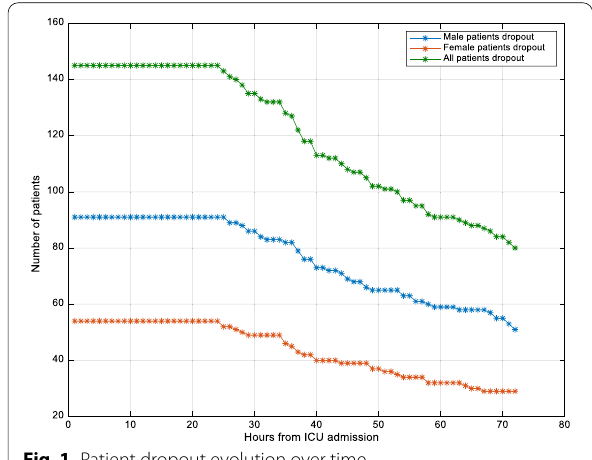
Fig. 1 Patient dropout evolution over